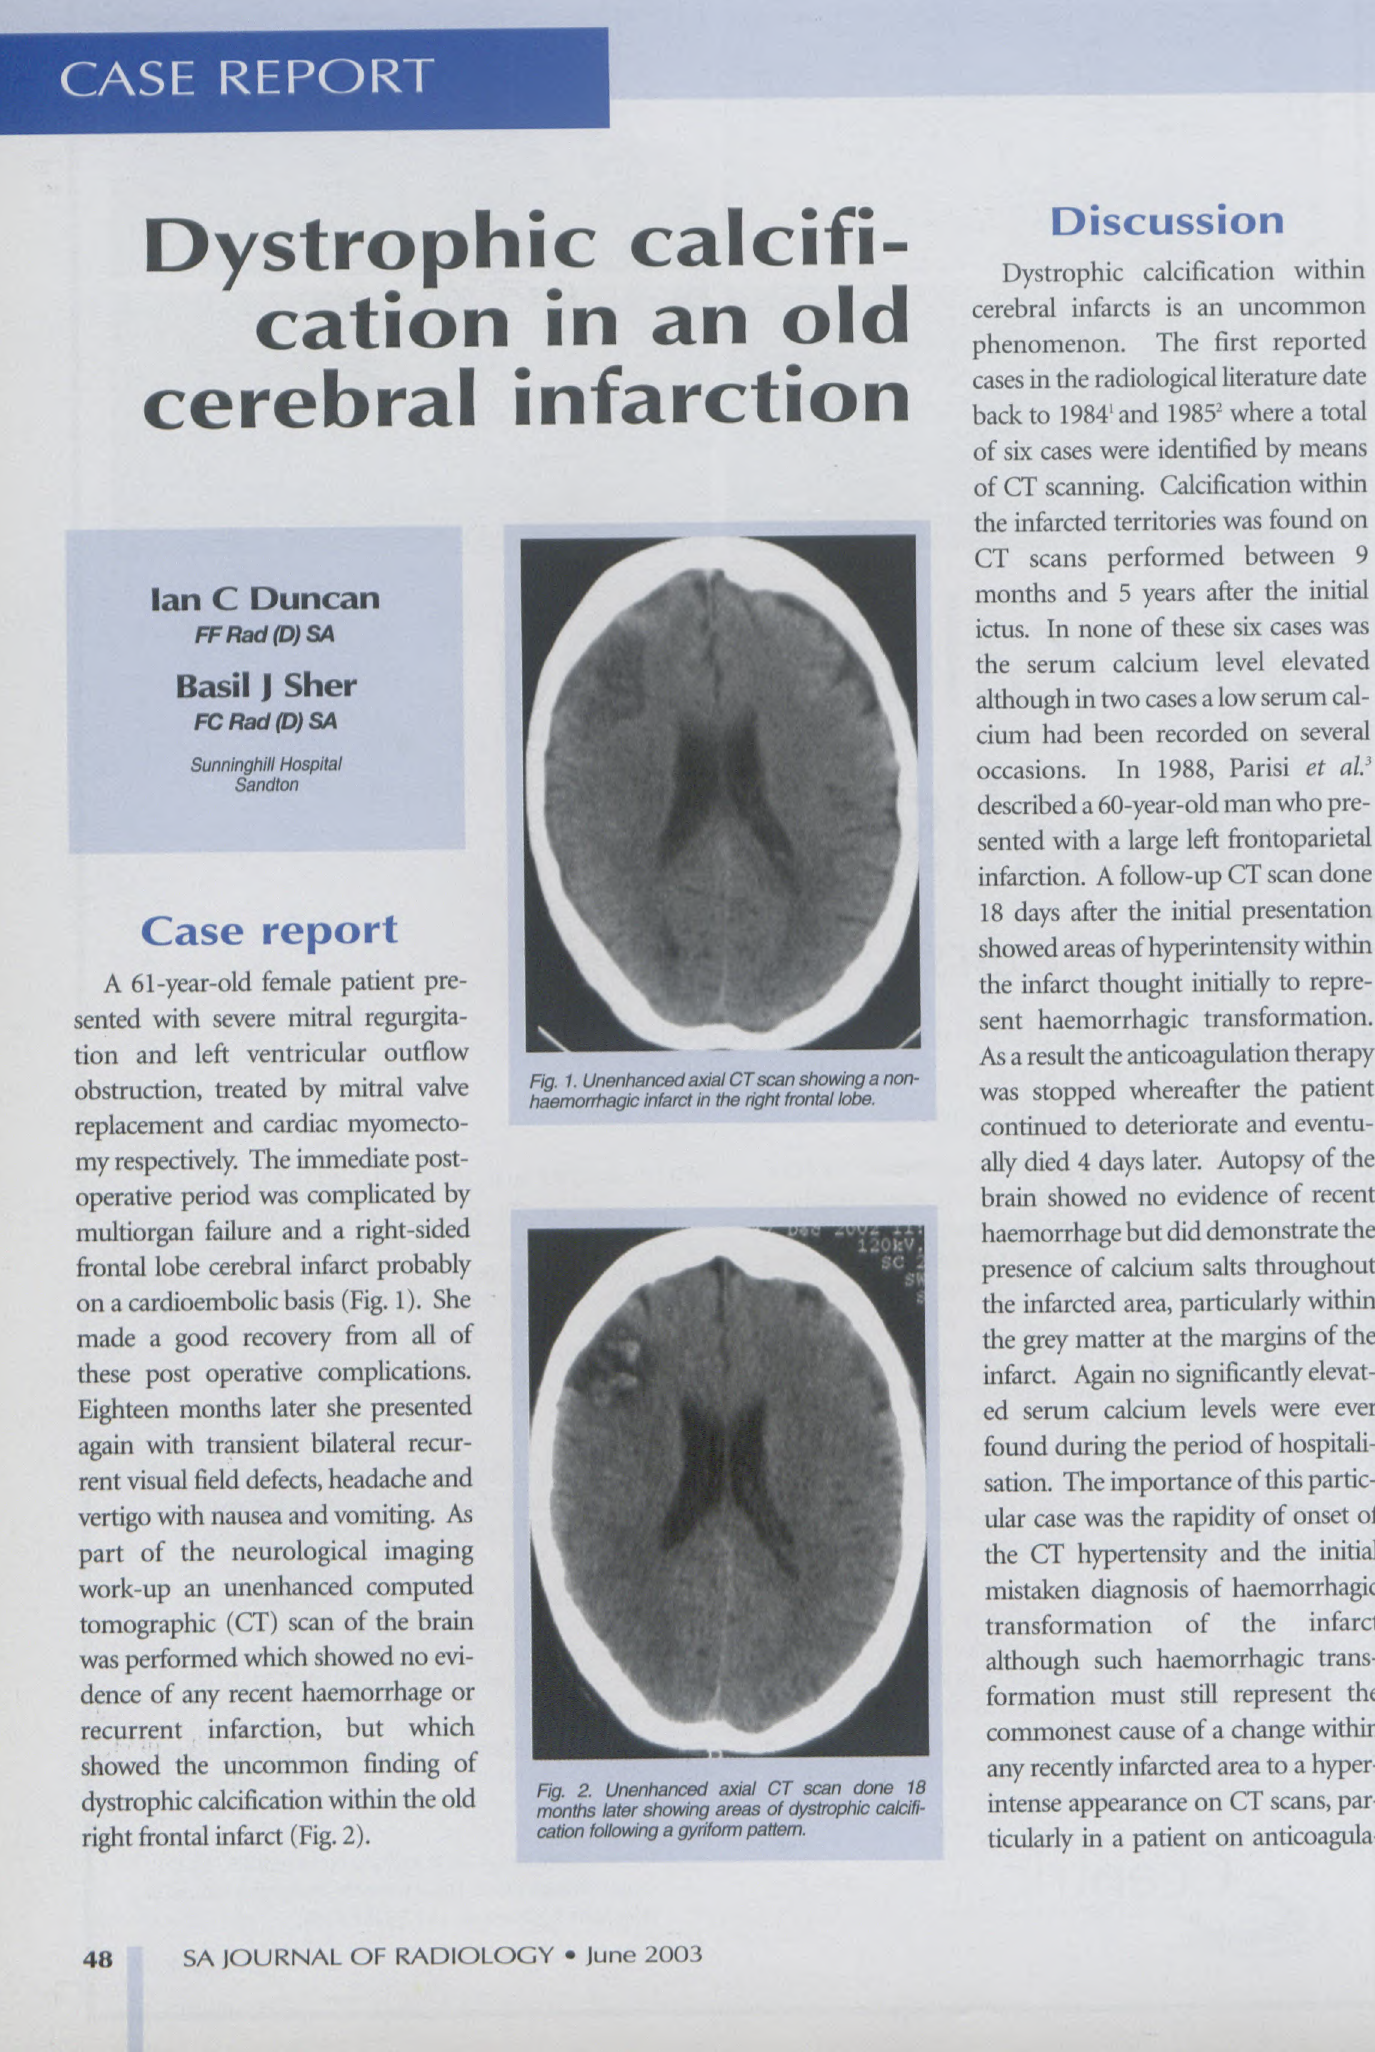
Fig. 2. Unenhanced axial CT scan done 18 months later showing areas of dystrophic calcifi- cation foJ/owing a gyriform